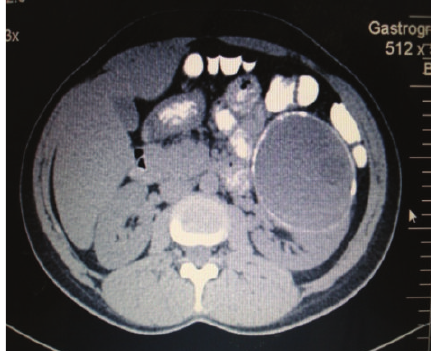
Figure 1: CT imaging revealing the 14 cm left renal cystic mass.